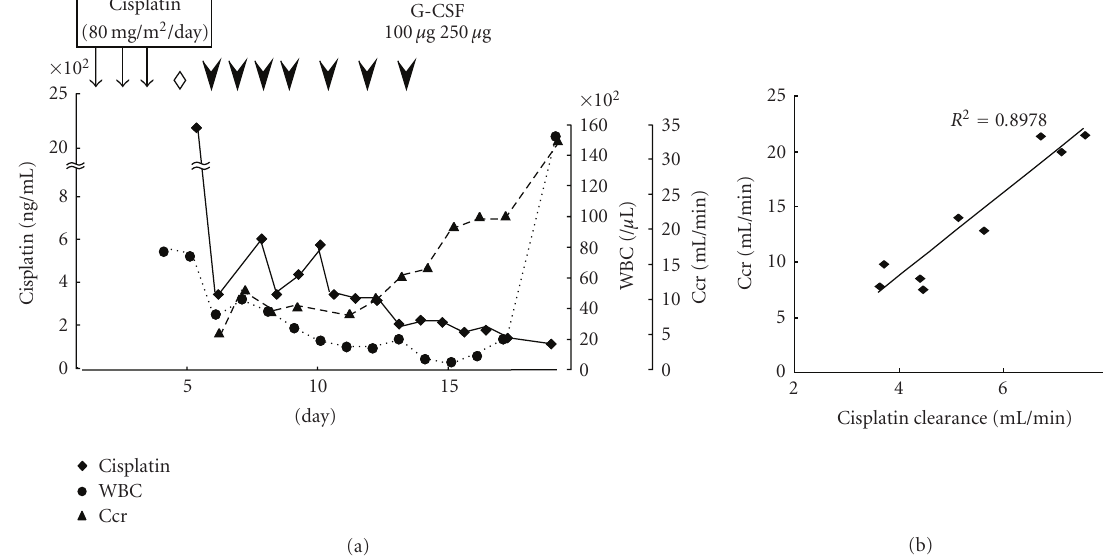
Figure 1: Plasma cisplatin concentrations, leukocyte counts, Ccr values and platinum clearance values. (a) An open diamond and arrow heads denote for dialysis and plasma exchange, respectively. (b) Note that cisplatin clearance approximately correlated with Ccr. WBC: white blood